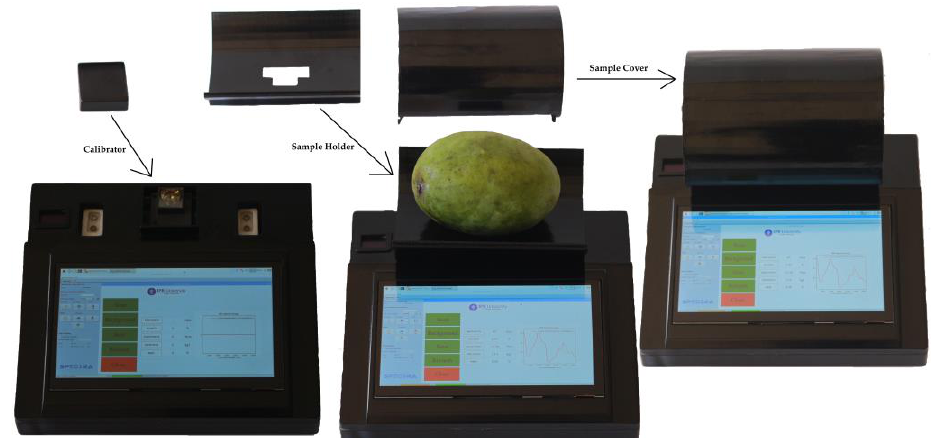
Figure 2. Portable NIR spectroscope.